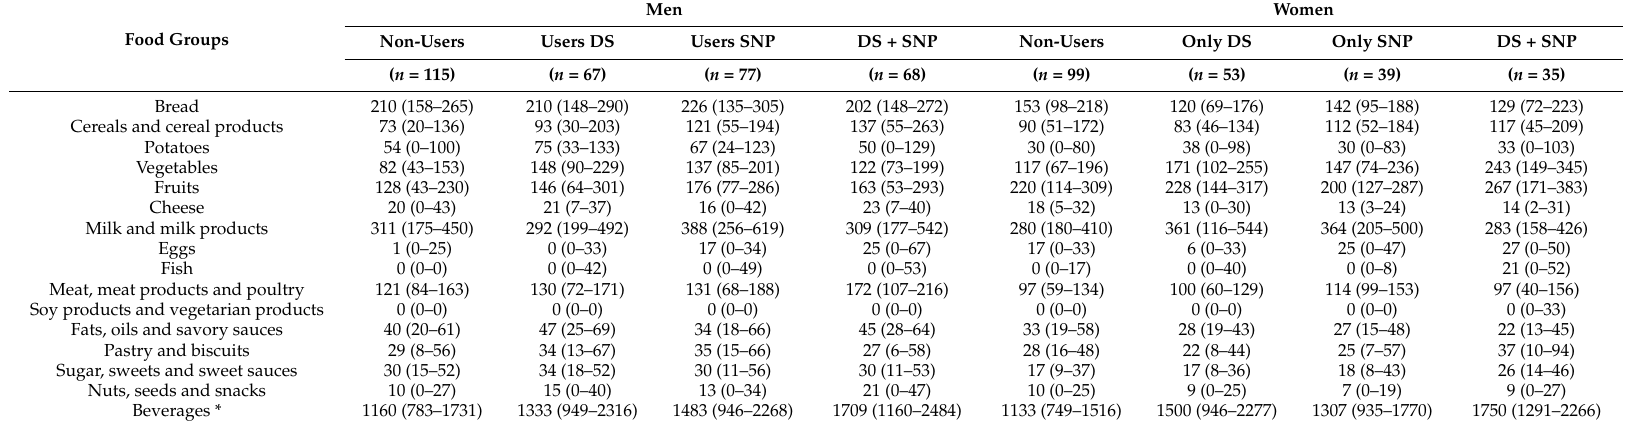
Table 2. Median (25–75 percentile) intake (g) of basal nutrition food groups per gender and